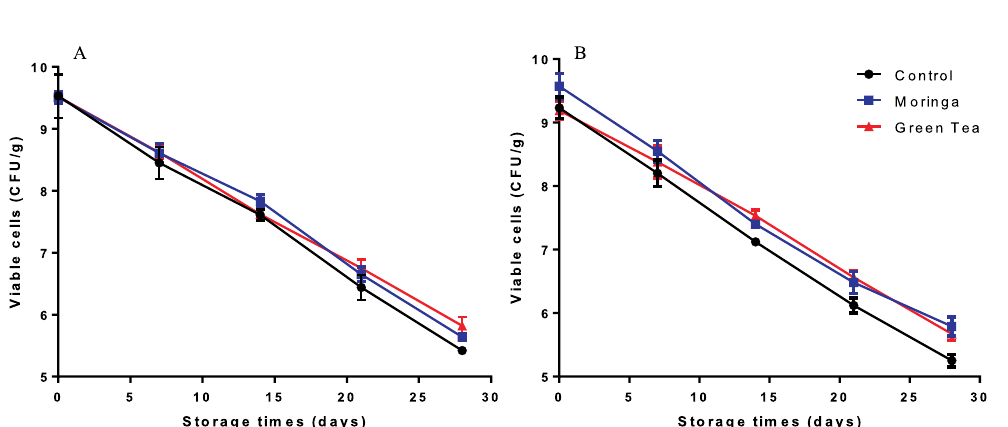
Fig. 3. Viable cells of control encapsulated probiotic cells (CC) and novel encapsulated probiotic cells (NC) with herbal extracts in drinkable yoghurt during refrigerated storage. (A) Lactobacillus plantarum DSM 20205, (B) Pediococcus acidilactici DSM 20238.